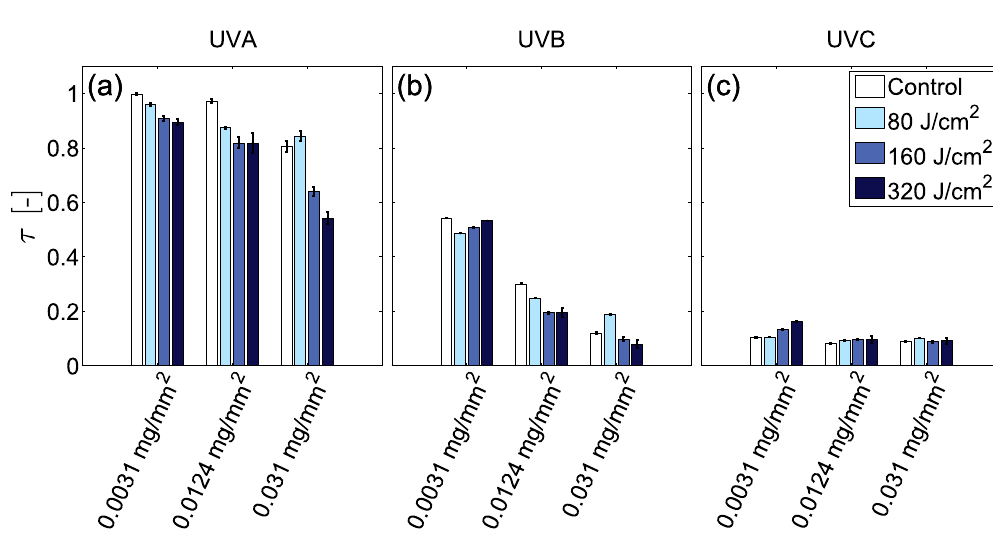
Figure 5. Effect of UVB dosage on UV film transmittance. Average DNA film transmittance, τ , in the ( a ) UVA range (315–400 nm), ( b ) UVB range (280–315 nm) and ( c ) UVC range (200–280 nm) prior to UVB exposure (open bar) and after UVB irradiation with dosages of 80, 160 and 320 J/cm 2 (respectively denoted by increasingly dark bar colors). Error bars denote standard deviations of n = 3 individual